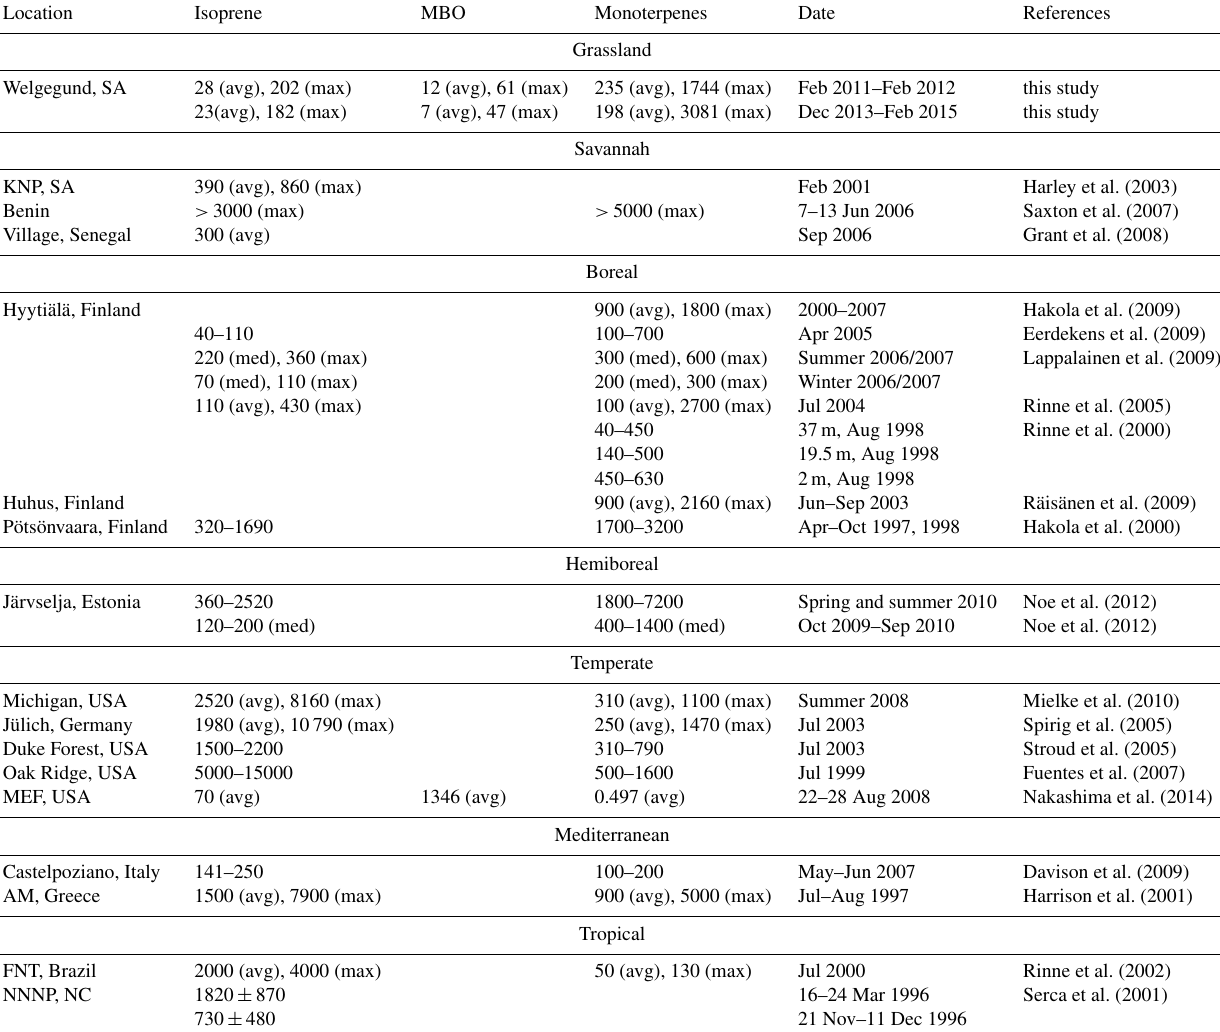
Table 3. Ambient BVOC concentrations (pptv) as reported by Noe et al. (2012) for various ecosystems and then modified: avg – mean value, med – median value, and max – maximal value of the measurements